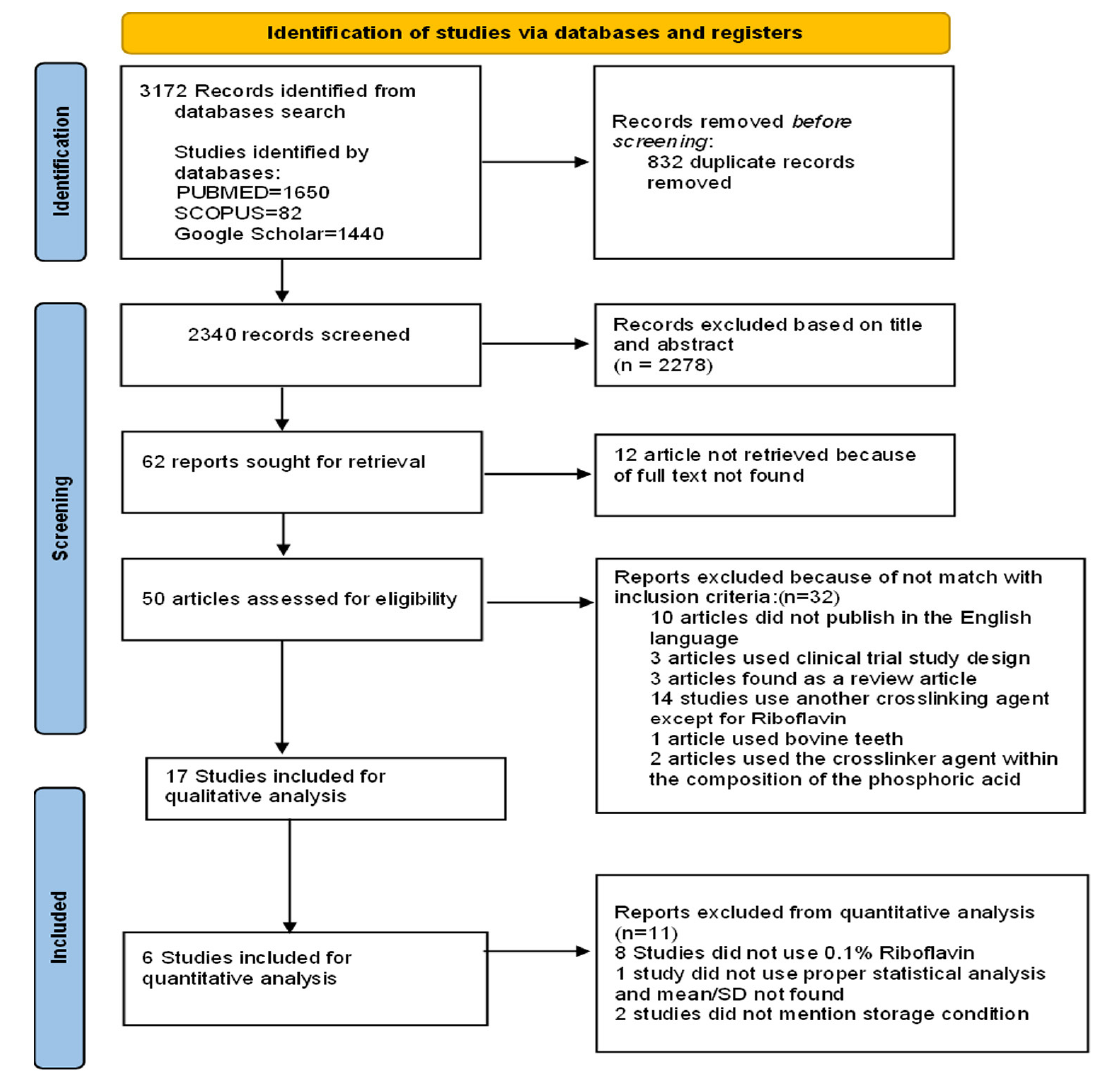
Figure 1. PRISMA flow chart of the study. PRISMA 2020 flow diagram for new systematic reviews which included searches of databases and registers only.